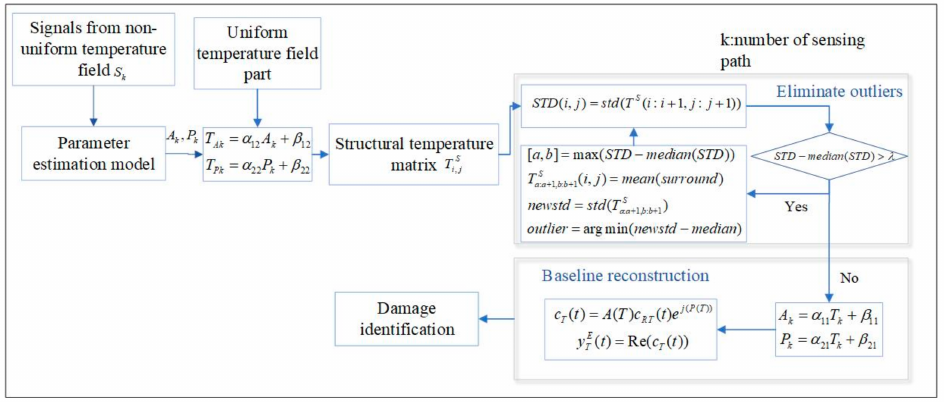
Figure 3. The detailed process of temperature field identification and